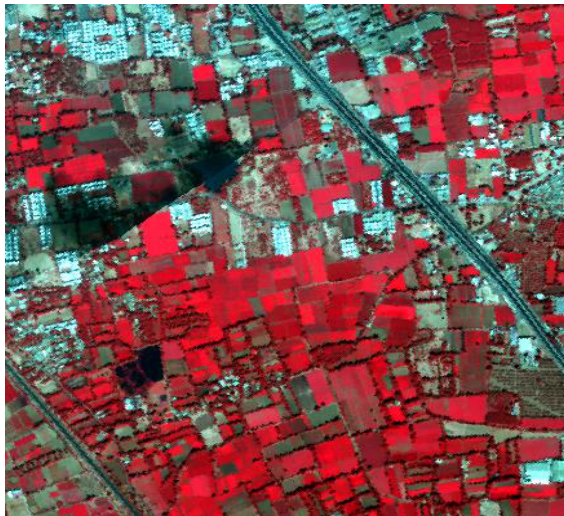
Figure 8. Reconstructed False Color Composite(FCC) image using 10 nodes in bottleneck